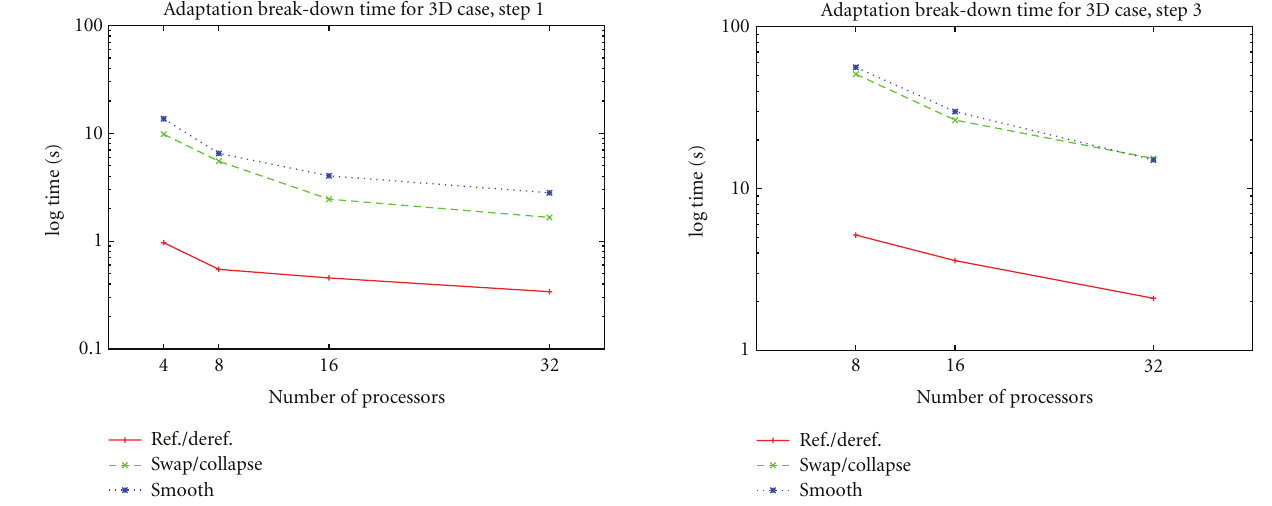
Figure 25: Execution time for adaptation blocks on multiple proc- essors. 3D wedge, third adaptation step.